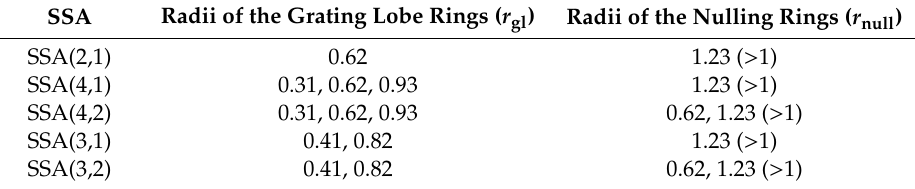
Figure 12. One-way, CW responses of ( a ) the sunflower array and ( b – f ) the SSAs. The radii of the grating lobe rings are indicated by white dots, and the radii of the nulling rings are indicated by green dots. A green dot in (d) is overlapped with the second white dot in the same plot. Table 2. Expected radii of the grating lobe rings and the nulling rings for the SSAs.